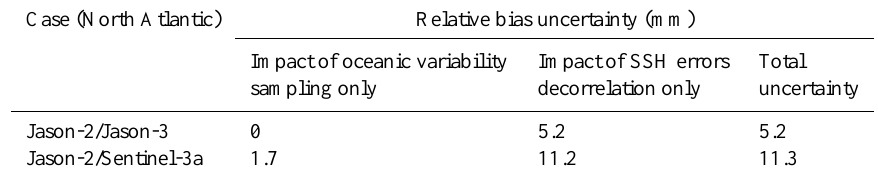
Table 3. Jason-2/Jason-3 and Jason-2/Sentinel-3a relative bias uncertainties on the North Atlantic mean sea